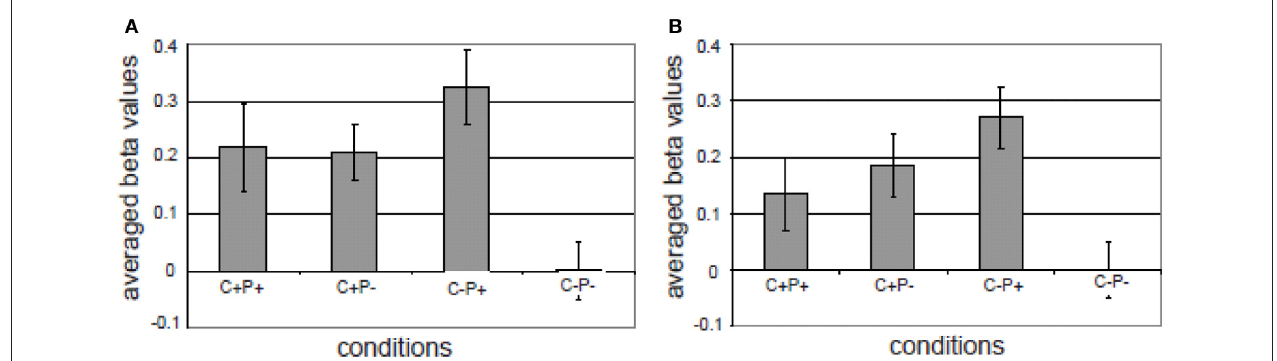
FIGURE 9 | Different activations in the four conditions in (A) left superior/inferior parietal cortex; (B) right superior/inferior parietal and right supramarginal region. The gray bars represent the averaged beta values of four conditions in the ROI (the activation in the C–P– condition was